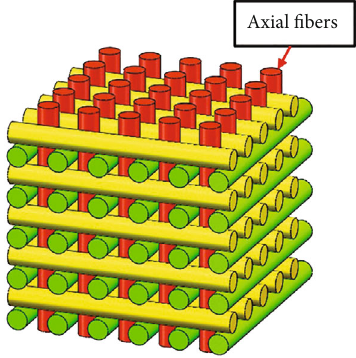
Figure 7: Schematic of strong arrangement.